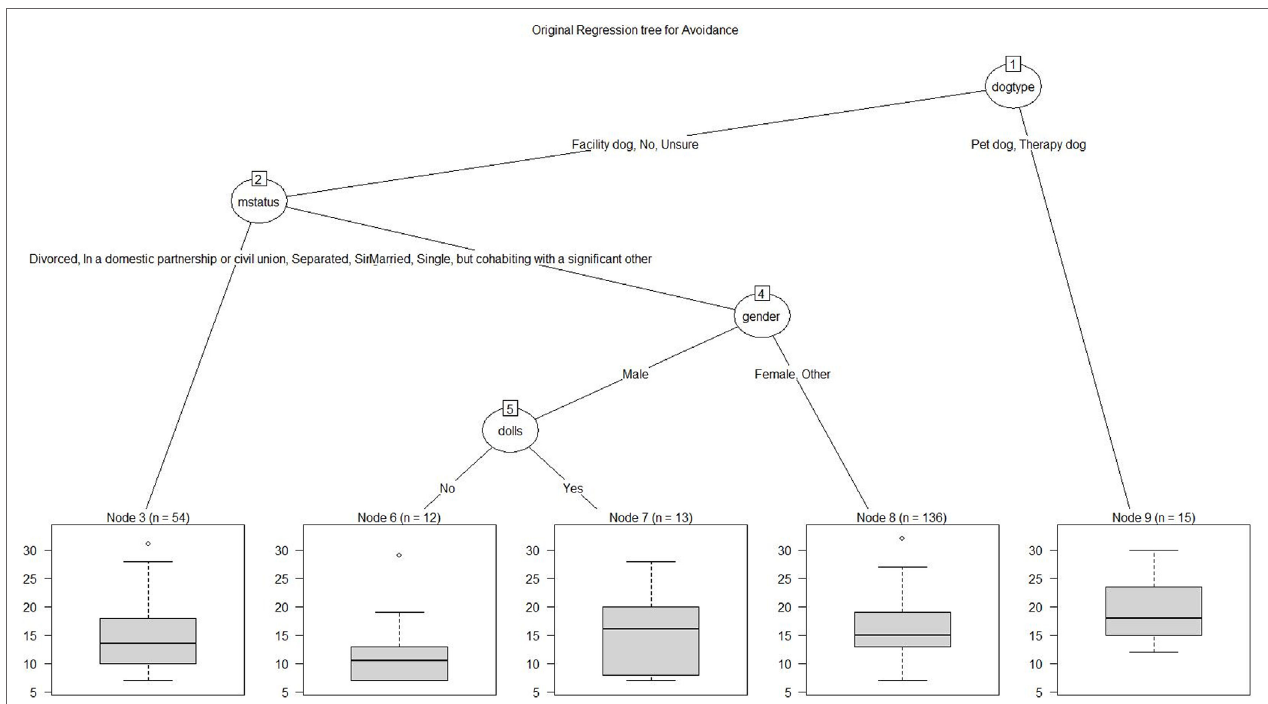
FigUre 2 | Regression tree plot for avoidance sub-scale scores. Node 1, therapy or pet dog vs. facility or no dog, p = 0.004. Node 4, partnered women vs. partnered men, p =